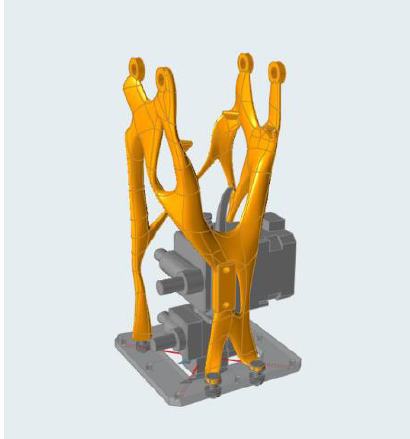
Figure 9. Remodeled component with PolyNurbs.